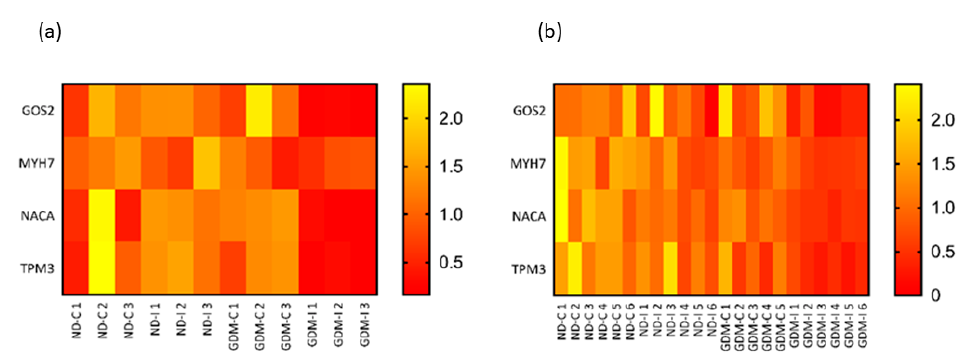
Figure 8. Relative heatmaps of RNA-seq ( a ) and qRT-PCR ( b ) used to validate and visualize biomarker